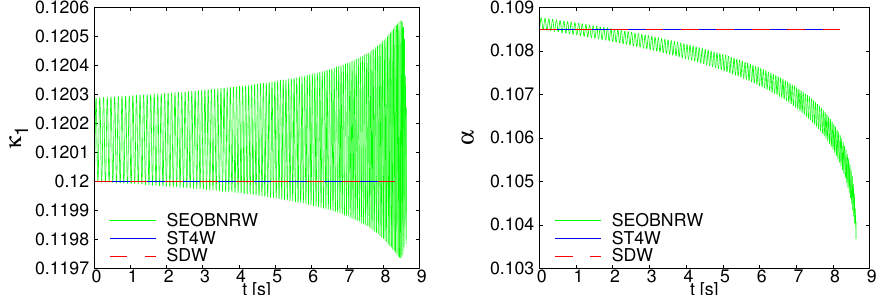
Figure 7. The evolutions of the angles κ 1 and α for SEOBNRv3 (green), SpinTaylorT4 (blue) and SpinDominatedWf